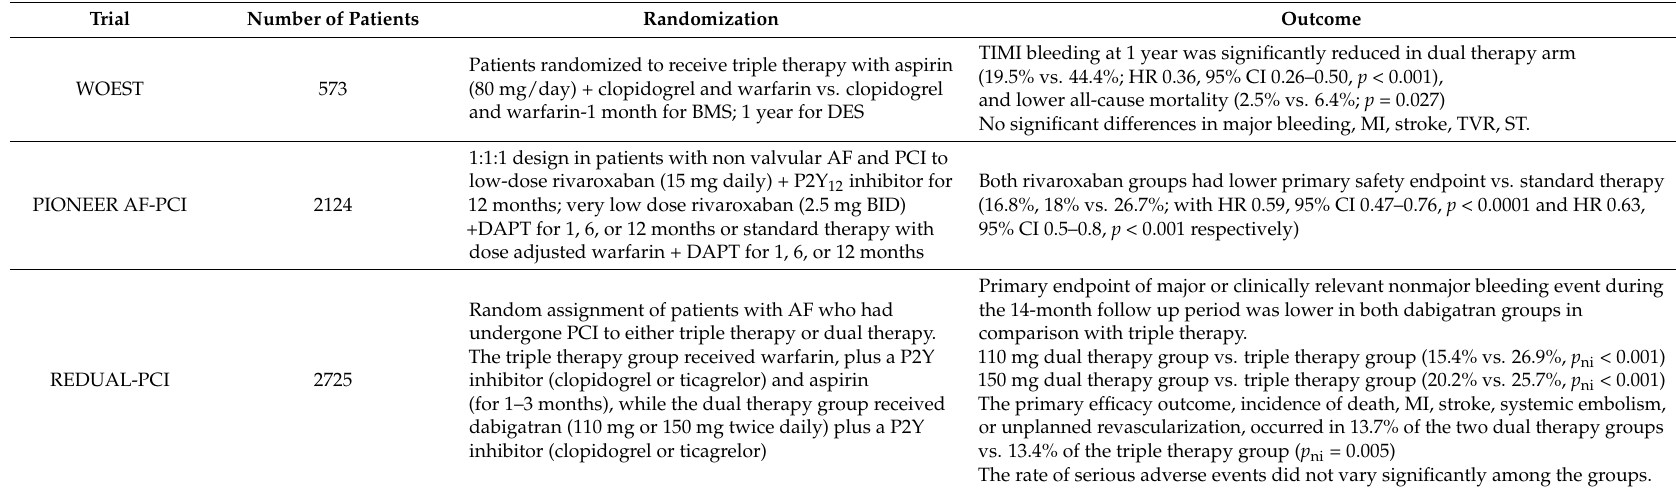
The rate of serious adverse events did not vary significantly among the